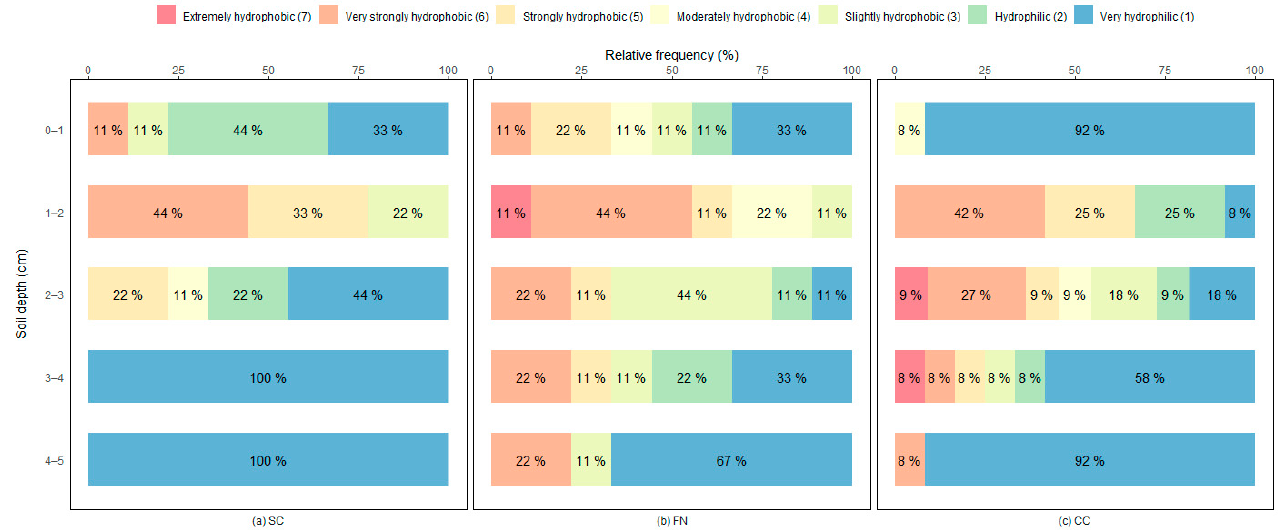
Figure 5. Relative frequency (%) of water repellency classes by soil depths (0–5 cm), which were measured by MED tests at different vegetation burn severity (SC, FN, CC) sites. The UB was very hydrophilic for all soil depths and was excluded from the figure.